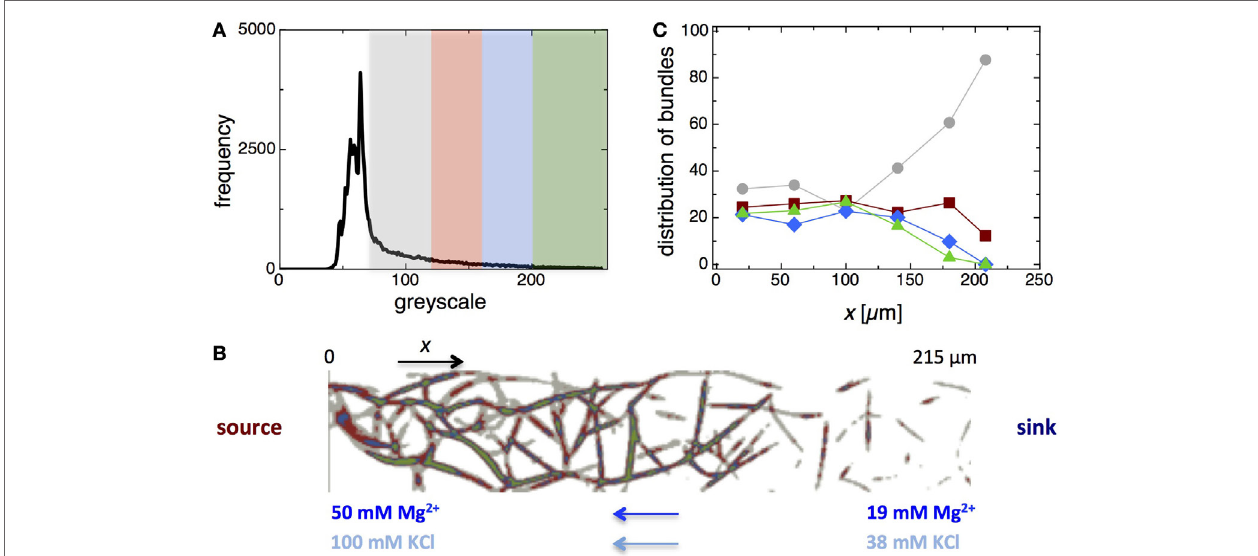
FigUre 5 | analysis of the distribution of bundle thickness within the F-actin bundle network . (a) Frequency histogram of grayscale values of the fluorescence micrograph of the F-actin bundle network ( Figure 4a ). The grayscale is divided into four segments that represent bundles of different thickness – gray represents bundles with filament numbers of n gray ~ 2–6, red with n red ~ 6–11, blue with n blue ~ 11–16, and green with n green ≳ 16. (B) Fluorescence micrograph of the bundle network colorized according to the amount of filaments within the network links. (c) Distribution of four classes of bundle thickness, i.e., number of filaments, in the network links versus the distance, x from the source of the double